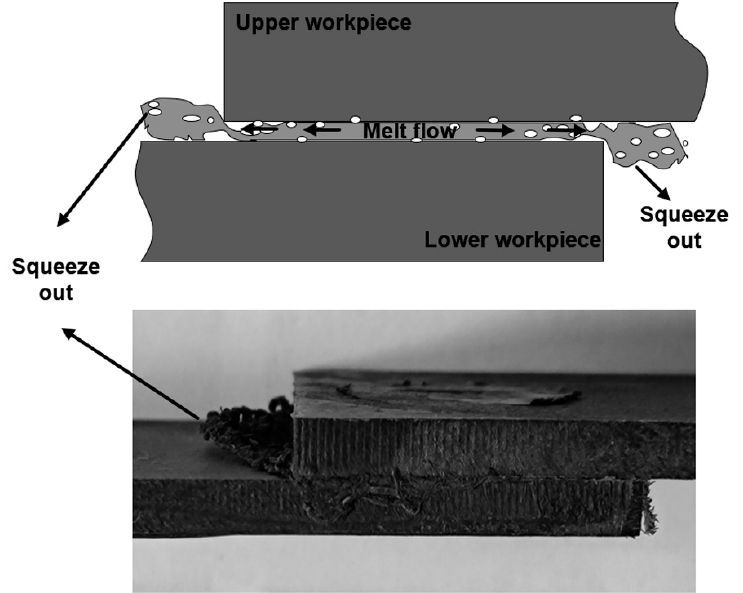
Figure 4. Morphology of the as-welded joint.